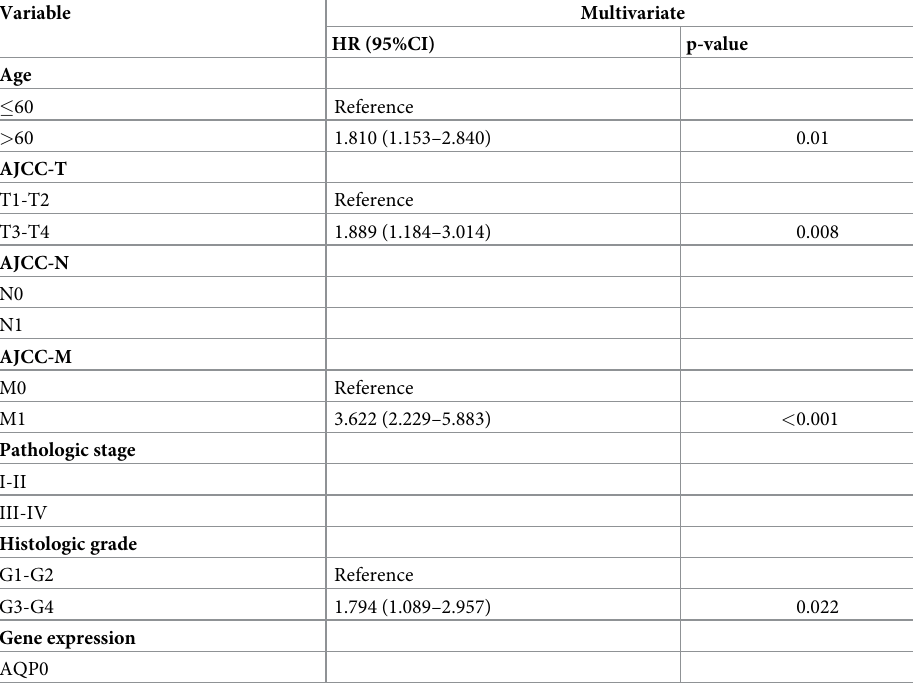
Table 5. Multivariate analysis of overall survival in 526 ccRCC patients.